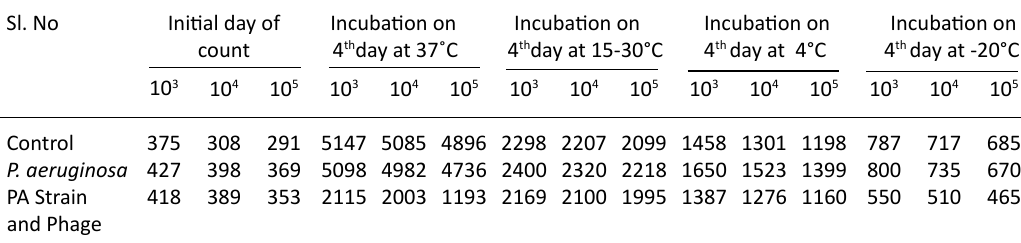
table 1. D. Showing physiological and morphological characterization of banana sample Days Appearance/ Colour